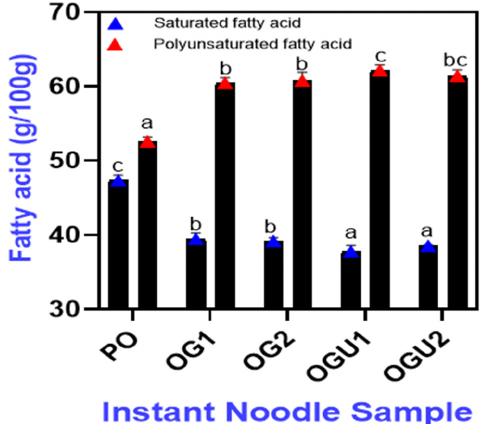
Figure 6. Cumulative level of saturated and polyunsaturated fatty acid content in the surface of SDEW instant noodles that are fried using palm oil, palm oil–carnauba wax oleogel and palm oil–carnauba wax oleogel with ultrasonication treatments. Note: PO represents palm oil; OG1 represents palm oil–carnauba wax (5 g/100 g); OG2 represents palm oil–carnauba wax (10 g/100 g); OGU1 represents palm oil–carnauba wax (5 g/100 g) homogenized with ultrasonication; and OGU2 represents palm oil–carnauba wax (10 g/100 g) homogenized with ultrasonication. The different alphabets (a–c, bc) in the figures indicate significant differences.